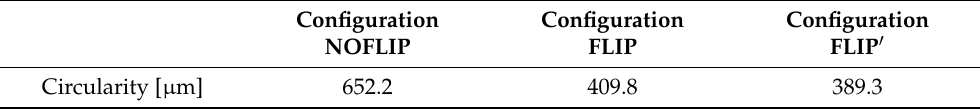
Figure 13. Polar graphs from measuring a circle on the inclined plane. ( a ) NOFLIP configuration; ( b ) FLIP configuration; ( c ) FLIP’ configuration (coordinate R = 180 ◦ ). Table 6. Average circularity value for measuring a circle on the inclined plane.